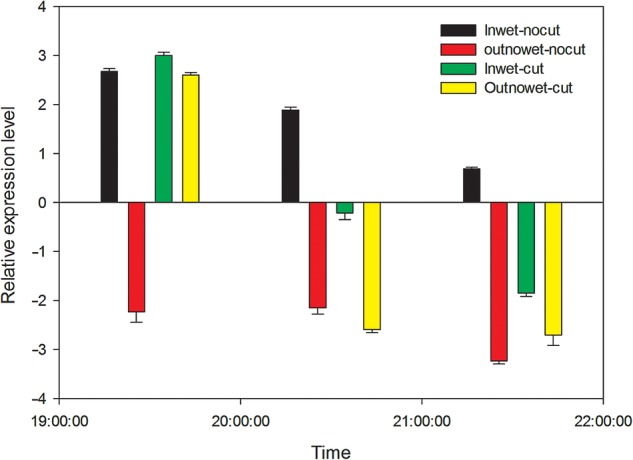
Impact of air moisture and root pressure on expression level changes in PIP2-1 in natural field and control experiments. The humidity inside the chamber was over 85 %, and it was ∼50 % outside the chamber.